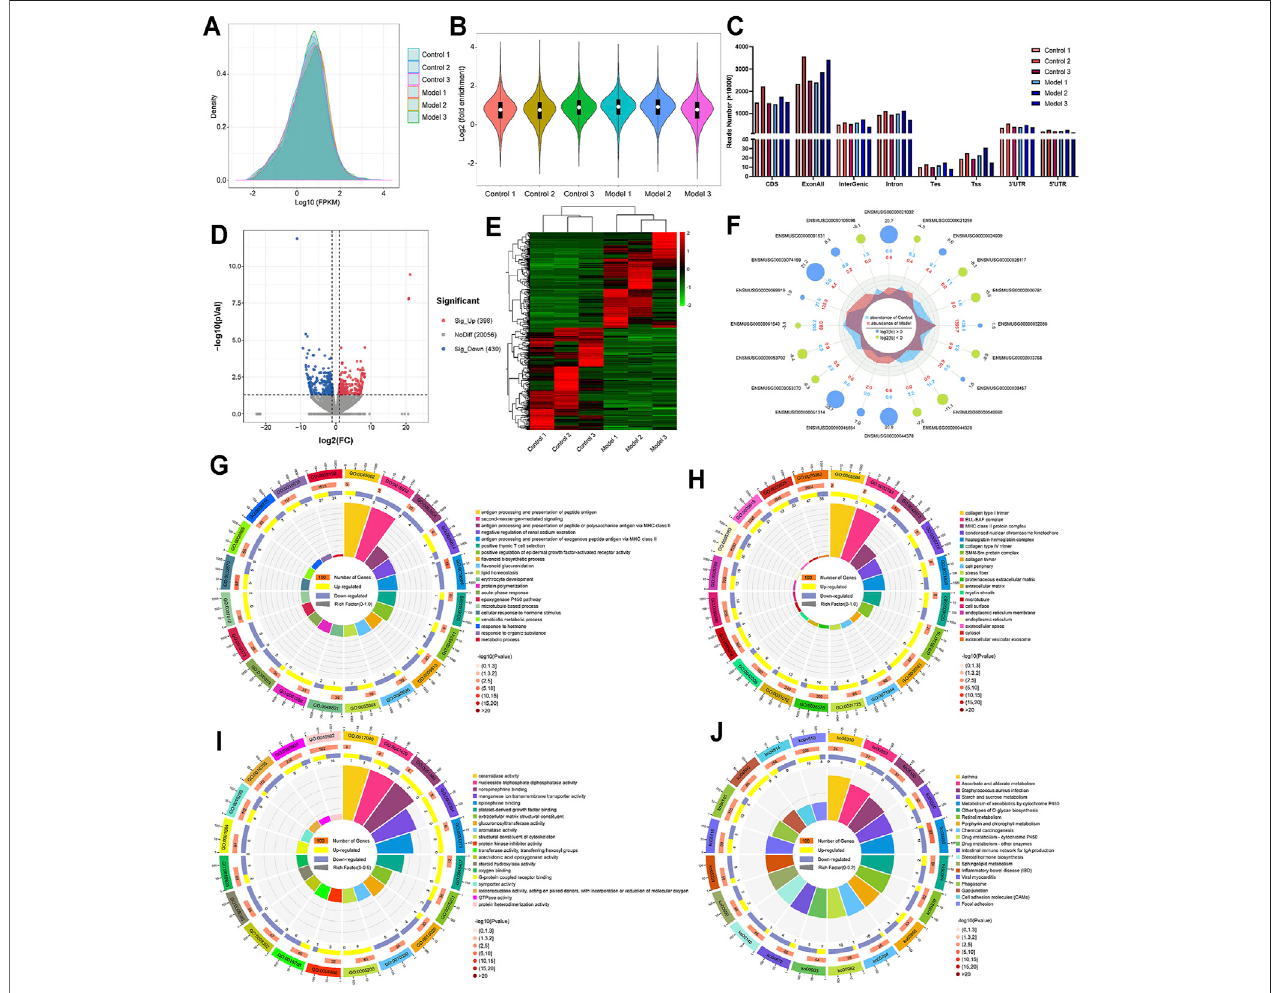
FIGURE 5 | The overall expression of mRNA and the description of differentially expressed mRNAs. (A) Metagene plots reveal the distribution intensity and abundance of mRNA expression after sequence alignment. (B) Violin plot of the relative abundance of mRNA expression in each sample. (C) Regional distribution of mRNA. (D) Volcanoplotrepresentationofmicroarray dataonthedifferentially expressed mRNAgenes. (E) Hierarchicalclusteranalysisofdifferentially expressed mRNA genes. (F) Theradarmapshowsthetop10upregulatedgenesandtop10downregulatedgenes. (G) GObiologicalprocessesenrichmentanalysis. (H) GOcellular component enrichment analysis. (I) GO molecular function enrichment analysis. (J) KEGG enrichment analysis.